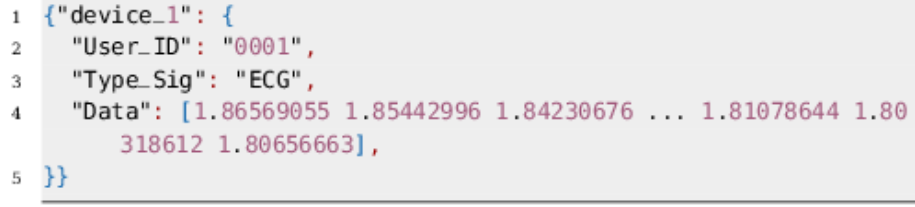
Figure 6. The data structure employed by ESP-32 to send the